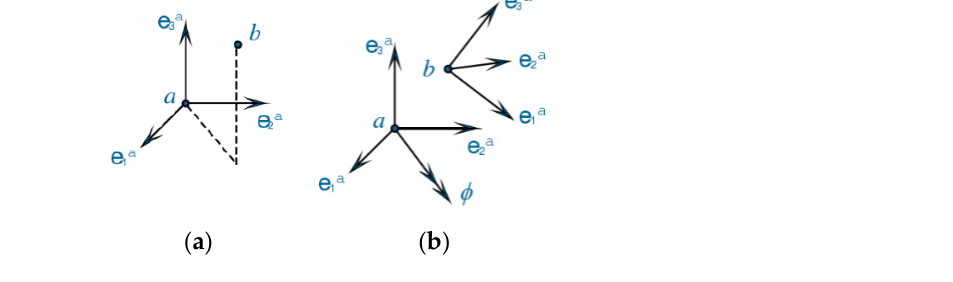
Figure 15. Translational and rotational relations of the Cartesian connector: ( a ) translational relation, ( b ) rotational relations.